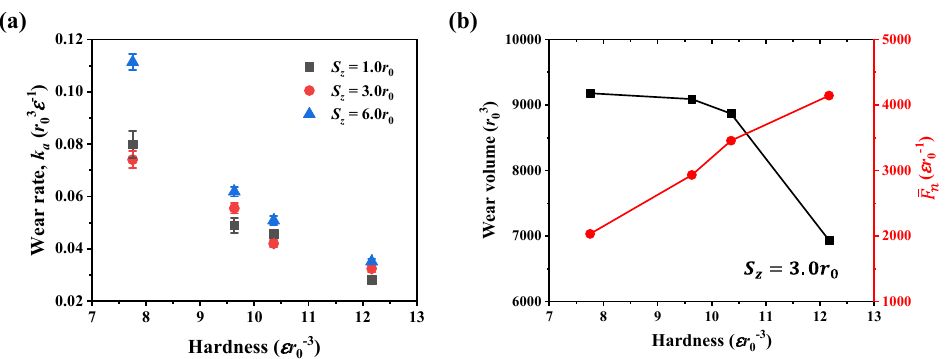
Figure 9. ( a ) Wear rate in materials of different hardness. ( b ) Wear volume and averaged normal force at the scratch depth of 3.0 r 0 .